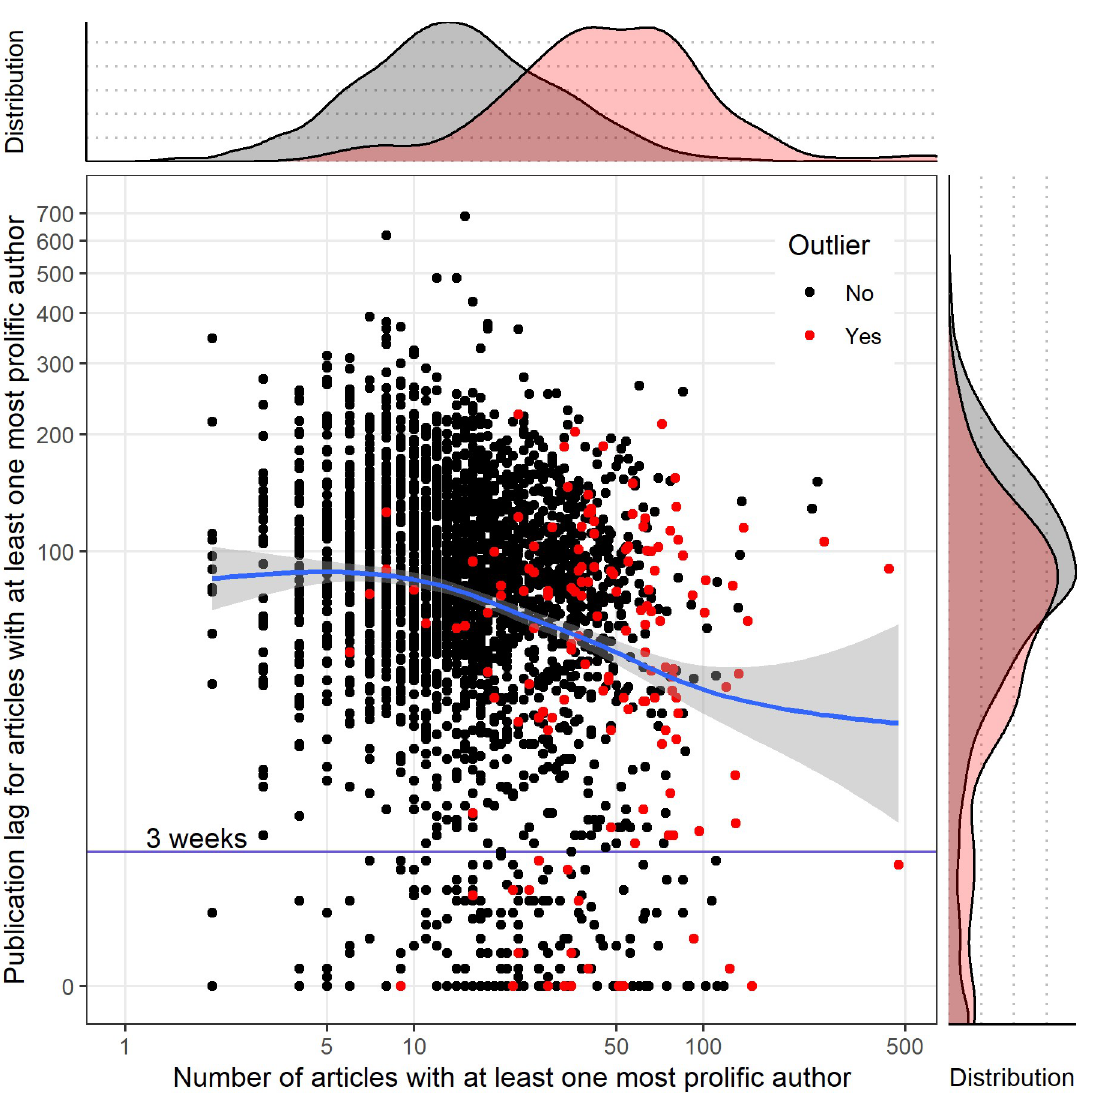
Fig 4. Publication lag among articles of the most prolific author. Distribution of publication lag (in days) and number of articles authored for each of the most prolific authors, across all articles (with marginal density plot of distributions) for the subgroup of 2,725 (49.8%) journals reporting submission and publication dates. The data underlying this figure may be found in